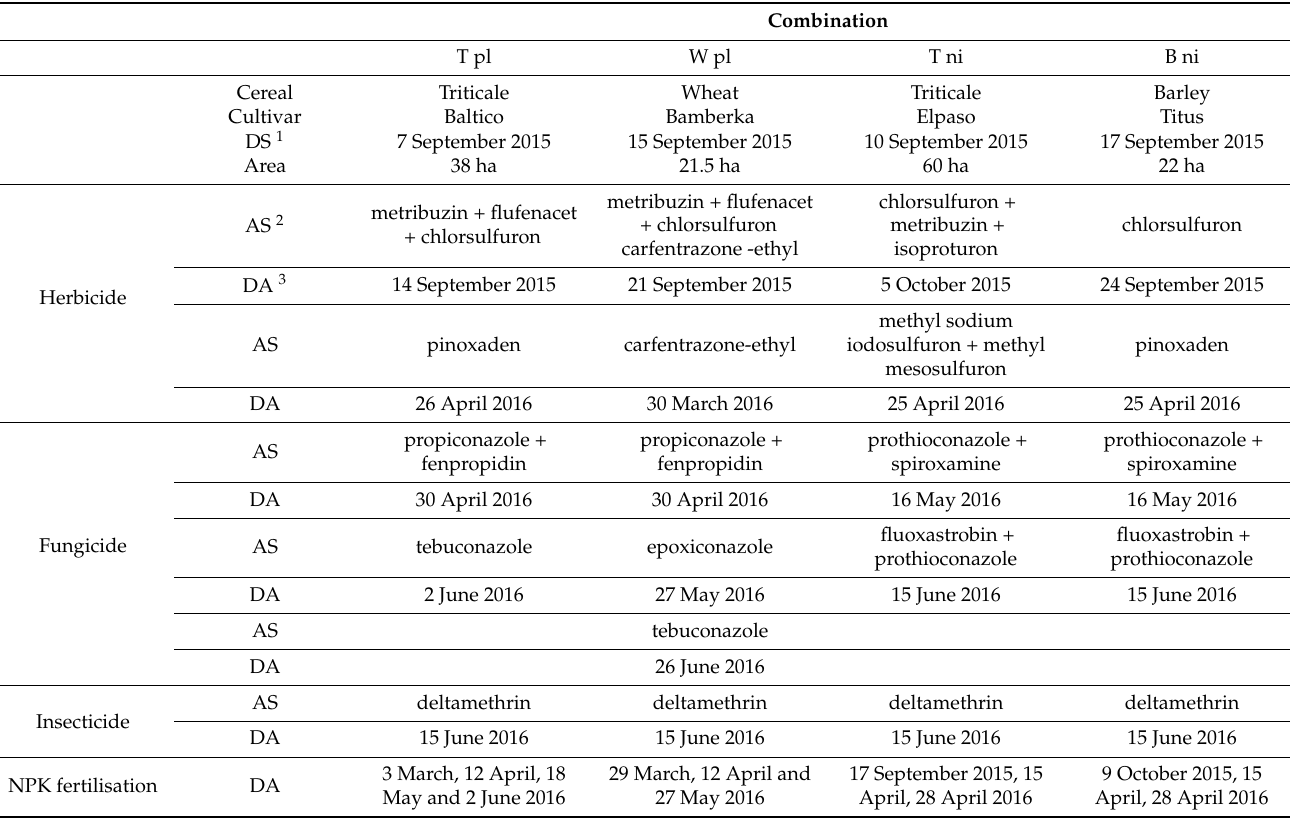
Table 1. Characteristic of cereals plantations alongside the specification of pesticides applied and